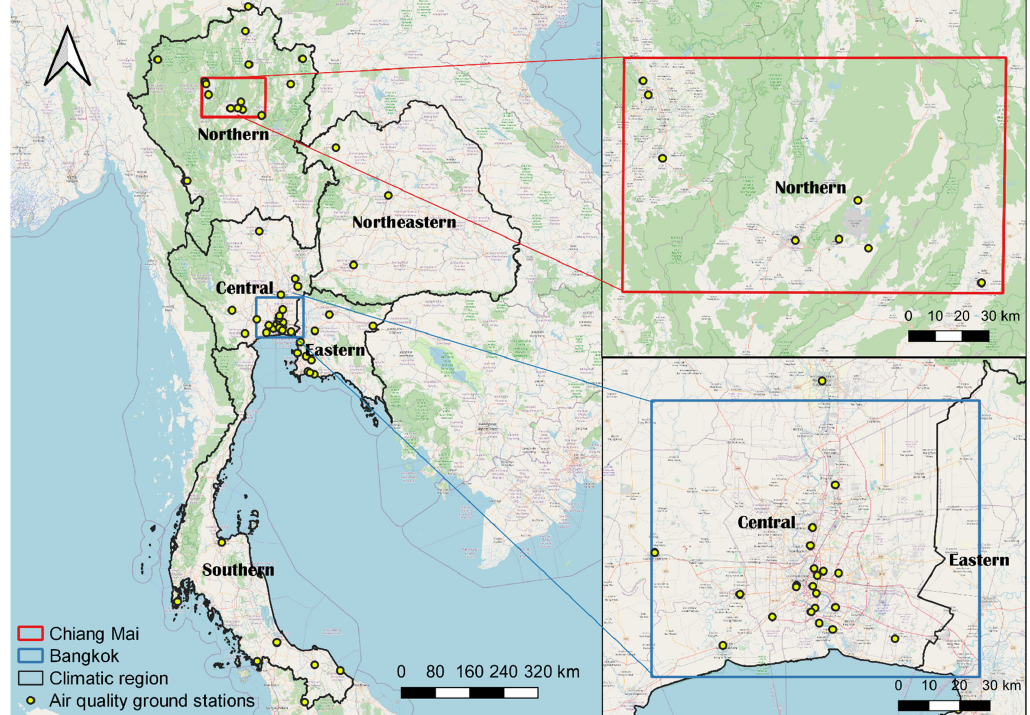
Figure 1. Study area with climatic zones subdivisions and locations of air quality ground stations (yellow points). Each bounding box covers the regions around Chiang Mai (red box; 98.90–100.24° E, 18.09–18.92° N) and Bangkok (blue box; 100.05–101.04° E, 13.45–14.29° N).